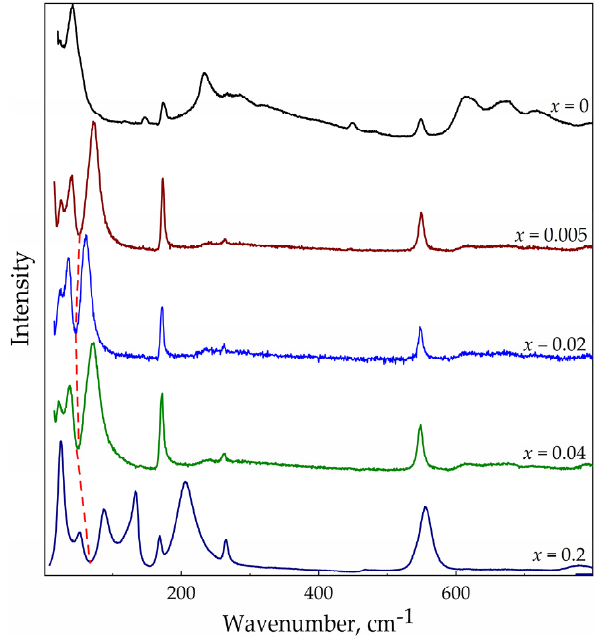
Figure 3. The Raman spectra of the PST x solid solutions with small amount of Pb ( x = 0.005, 0.02, 0.04) and their comparison with the Raman spectra of the pure SrTiO 3 and the PST x with x = 0.2 at 50 K.